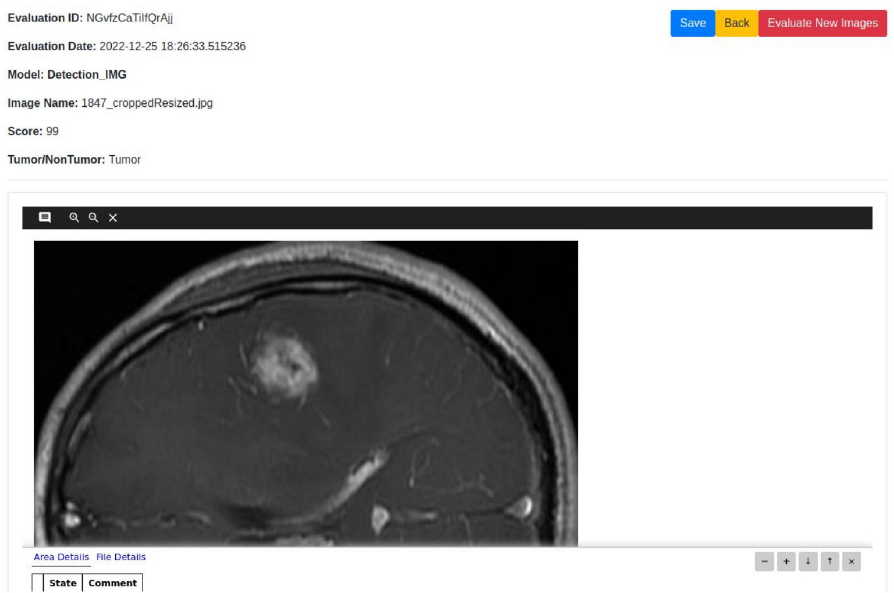
Fig 15. Tumor detection evaluation feedback